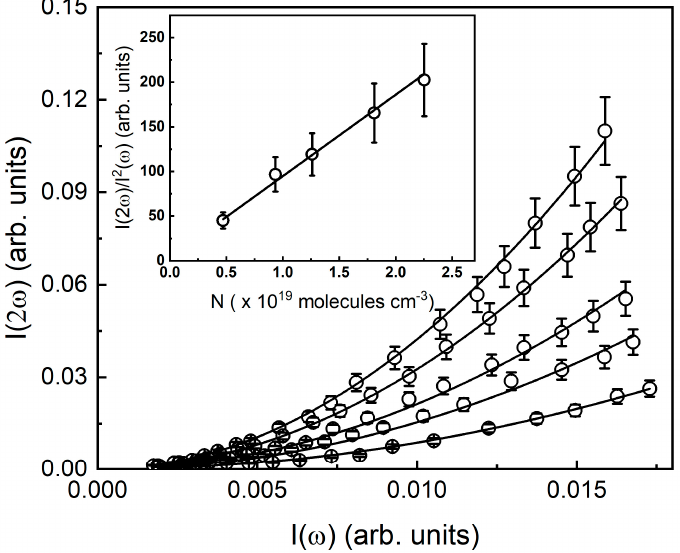
Figure 3. HRS signal as quadratic function of fundamental light beam irradiance for 4-DMDBA dissolved in dichloromethane (open circles). The inset shows the linear dependence between the (I(2 ω )/I 2 ( ω ) and the density of molecules.